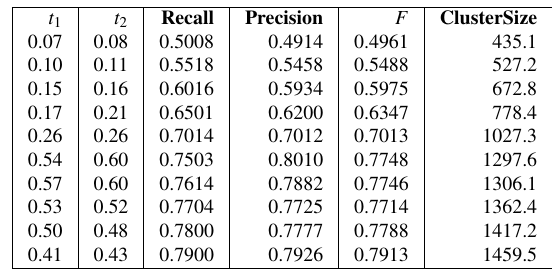
Table 2. Tests of f simple = classifier with feature selector b t , t